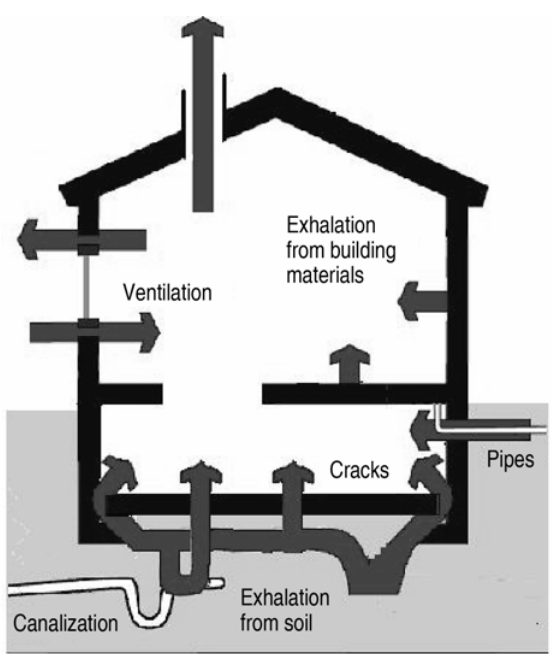
Fig 1 . Radon entry routes in